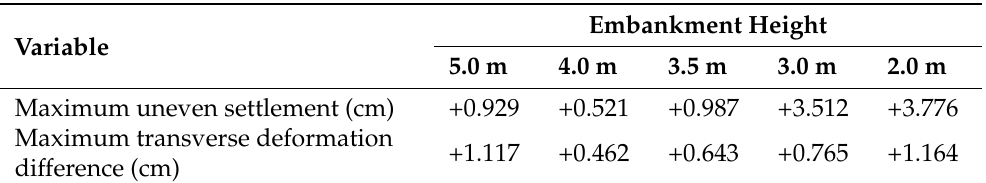
Table 5. Summary of the maximum uneven settlement and maximum transverse deformation difference between the shoulders and the road centerlines.